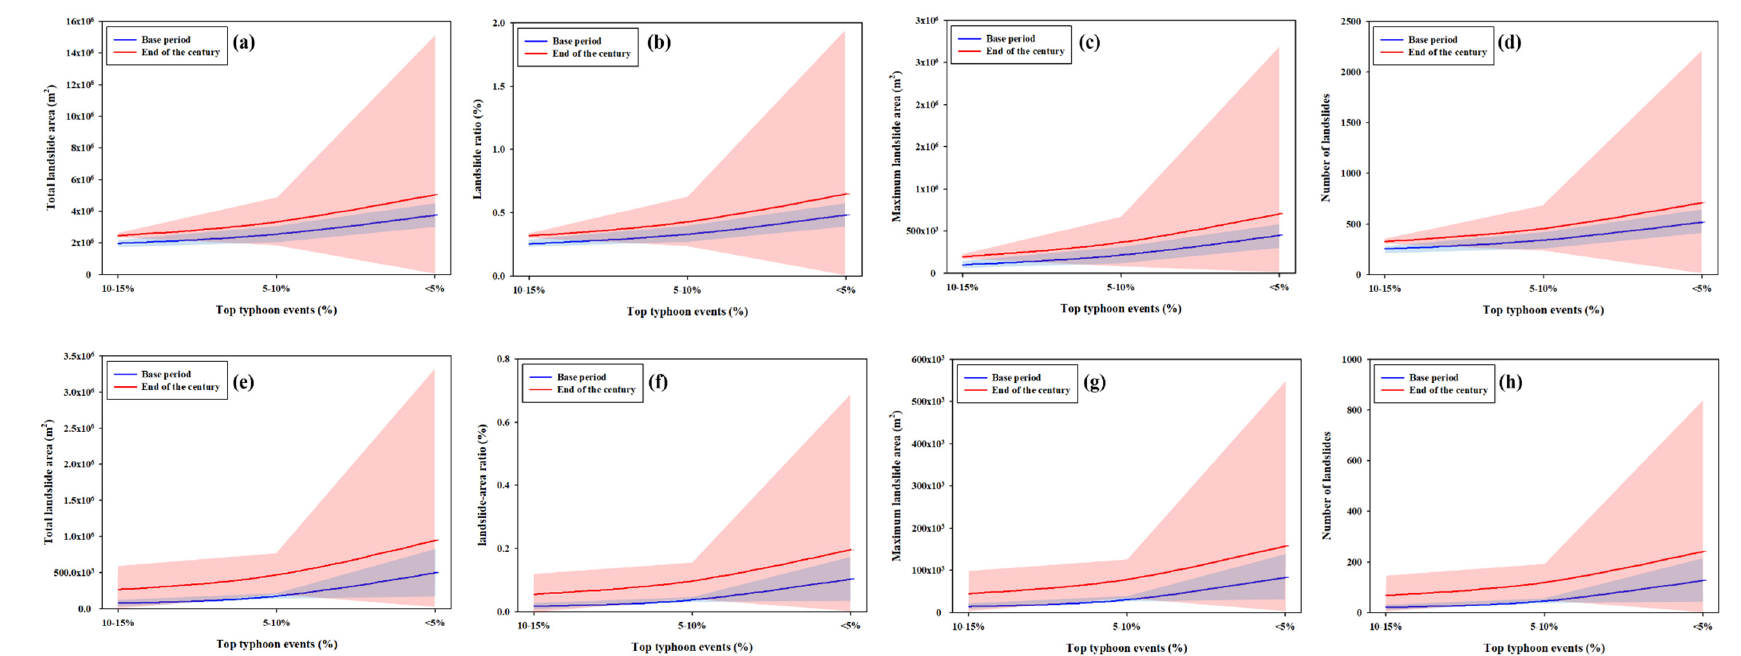
Figure 4. Landslide-area characteristics of the top 5%, 5%–10%, and 10%–15% typhoons during the base period and the end of the 21st century simulated only with the m01 and c0 scenarios. ( a – d ) are for the Shihmen Reservoir catchment and ( e – h ) are for the Xindian River catchment. Red and blue lines are mean values of landslide-area characteristics, with 95% confidence intervals in red and blue areas, respectively.